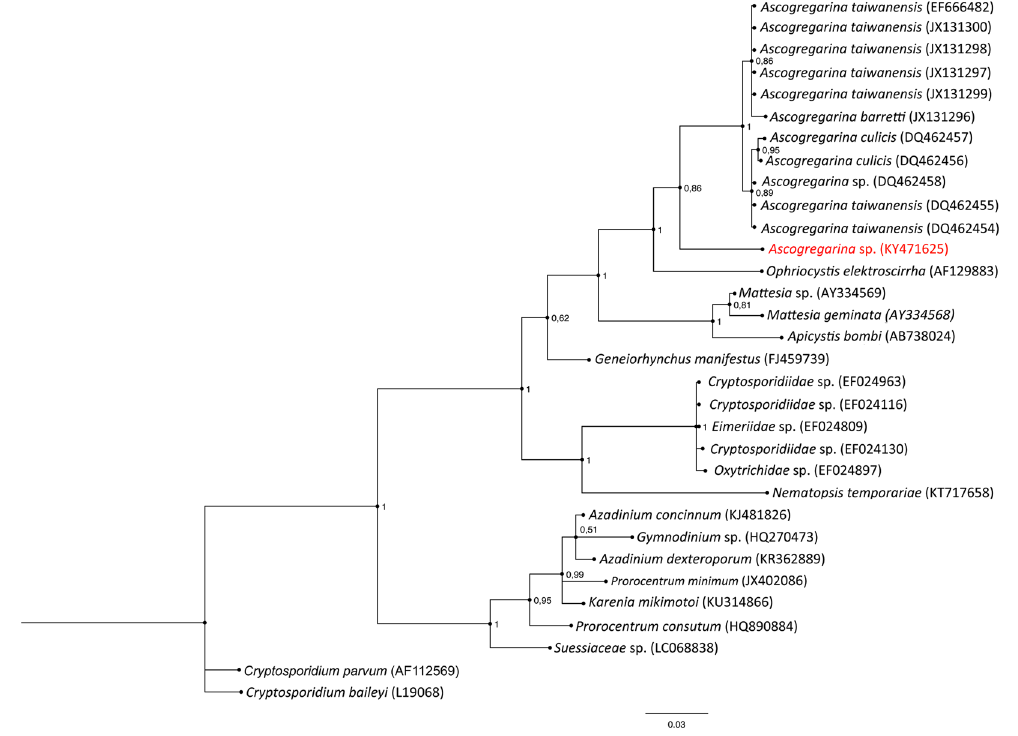
Figure 5. Bayesian tree inferred from partial SSU (small subunit) rDNA sequences showing phylogenetic position of the gregarine from T. castaneum . Cryptosporidium genus sequences were used as outgroup. Codes in parentheses represent GenBank accession numbers of partial SSU rDNA sequences. Posterior Probabilities (PP) values are shown with the